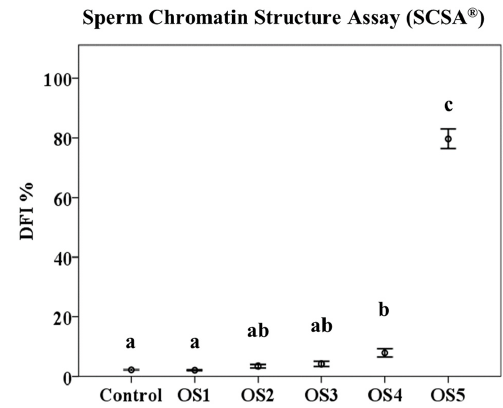
Figure 4. Effects of oxidant treatments on Sperm Chromatin Structure Assay (SCSA ® ) results. Mean of DNA fragmentation index (DFI %) ± standard error of the mean (mean ± SEM). a, b and c indicate significant differences ( p < 0.05). OS1 = 1 mM H 2 O 2 /0.1 µM FeSO 4 •7H 2 O; OS2 = 10 mM H 2 O 2 /1 µM FeSO